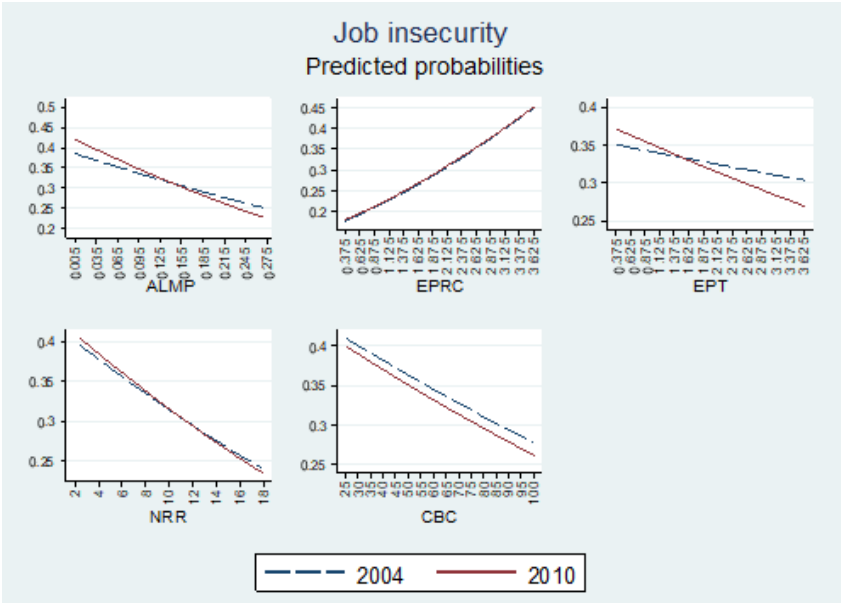
Figure 2. Institutions, job insecurity, and the crisis. Source: pooled data from the second and fifth waves of the European Social Survey. Notes: (1) For EPRC and EPT, the sample includes only temporary workers. (2) Predicted probabilities were plotted with the full set of controls. All control variables are set to their mean. (3) Likelihood ratio tests (Prob > Chi 2 ) for whether the interaction effect is statistically significant: ALMP = 0.02; EPRC = 0.93; EPT = 0.02; NRR = 0.61; CBC = 0.68. Confidence intervals are available upon request.